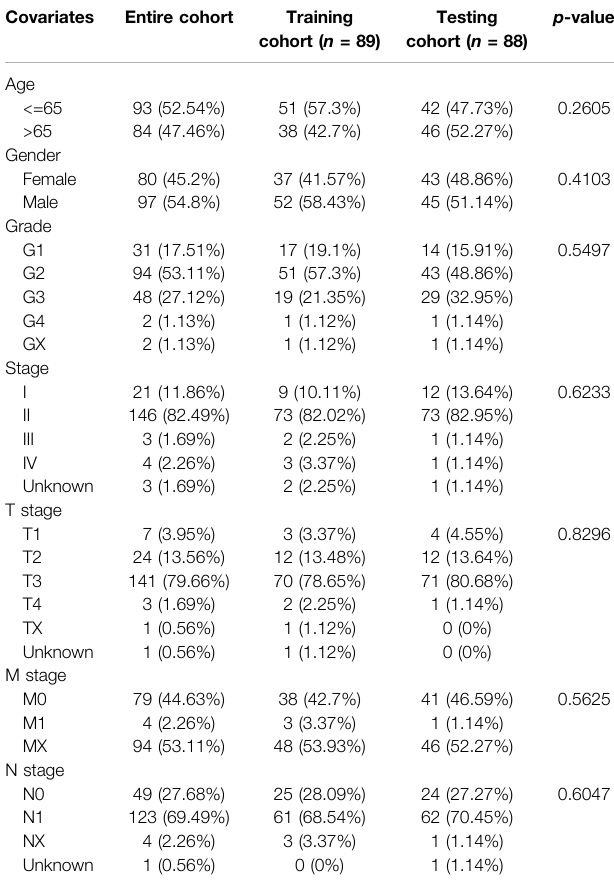
TABLE1| ClinicopathologicalinformationofPAADpatientsinthetraining,testing, and entire cohort. Covariates Entire